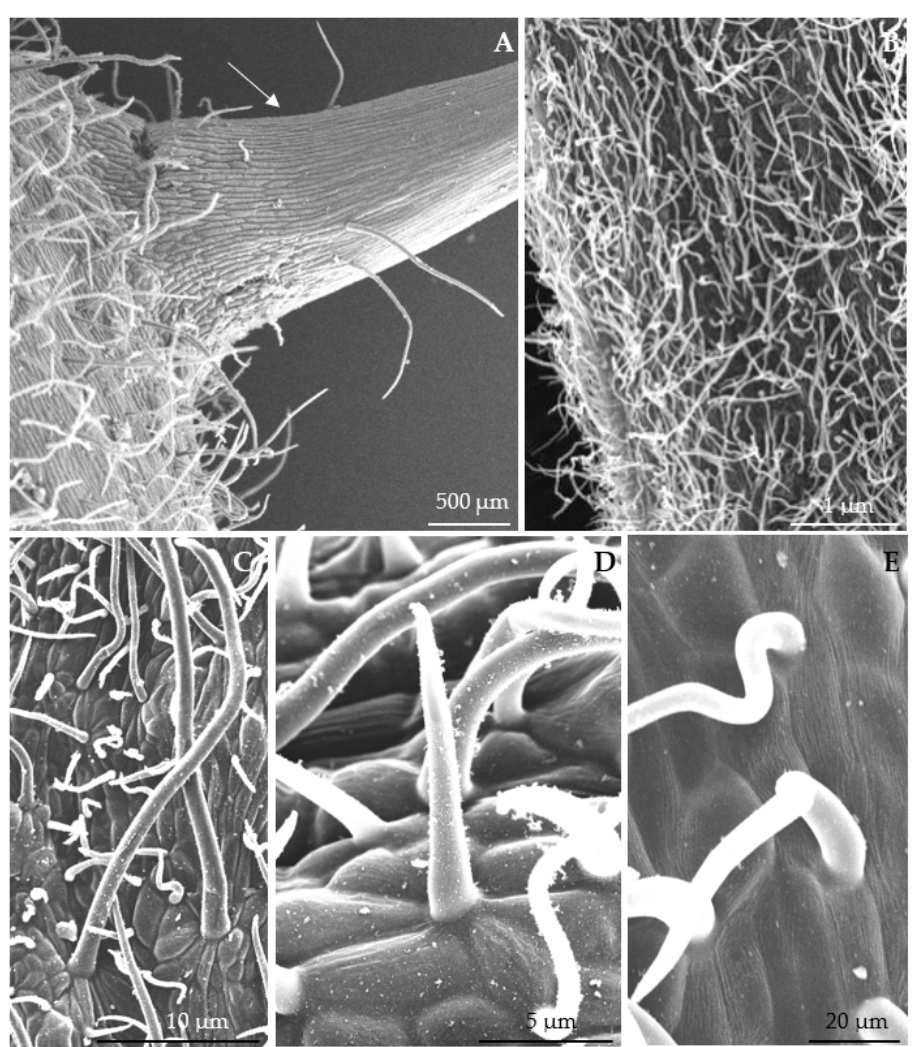
Figure 2. ( A – E ). Fragment of pedicel ( A ) and sepal ( B – E ) epidermis in R. idaeus ‘Laszka’ ( A ), ‘Glen Ample’ ( B ), ‘Radziejowa’ ( C ), and ‘Pokusa’ ( D , E ) in the initial secretion phase. ( A ): numerous non-glandular trichomes on the pedicel surface; visible epidermis cells covering a prickle (arrow). ( B ): abaxial face of the calyx epidermis with dense non-glandular trichomes. ( C – E ): adaxial face of the sepal epidermis; visible tapering unicellular non-glandular trichomes with various lengths; cuticle surface with delicate striation (photograph ( E )).